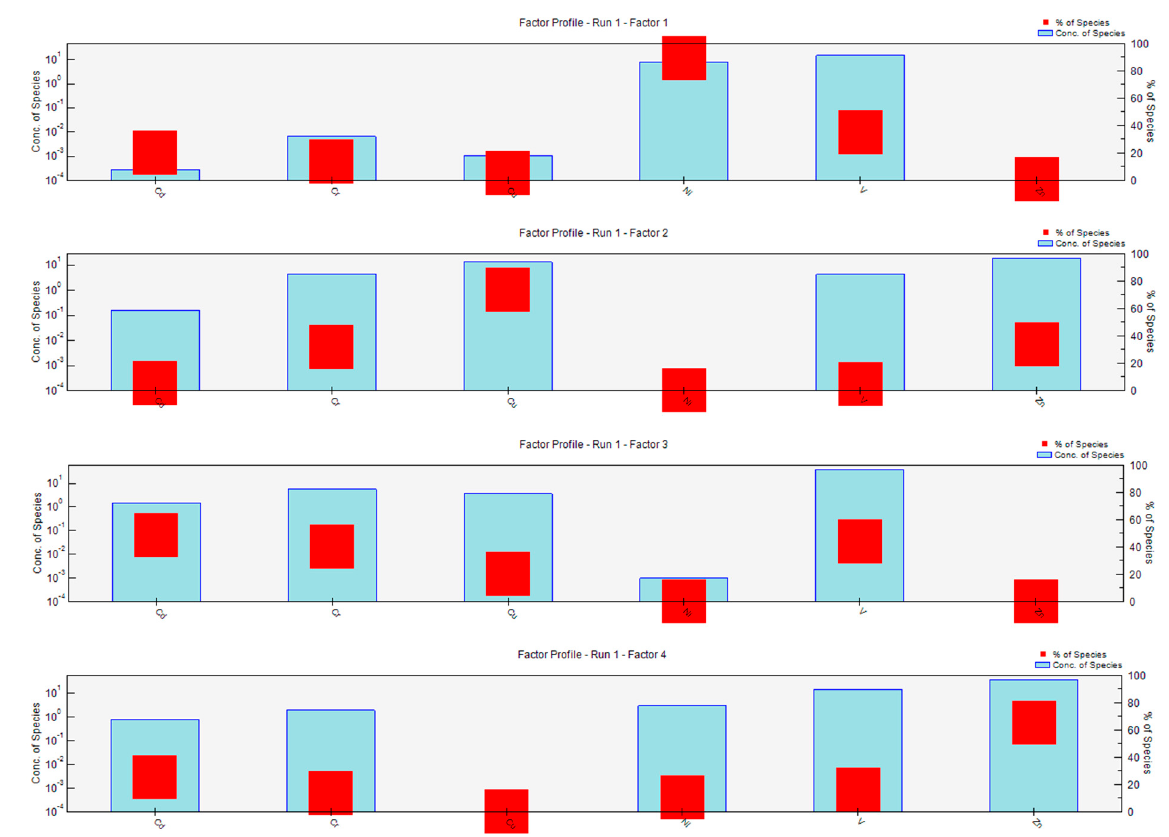
Figure 4. Summary of the PMF result, source profiles, and source contributions of heavy metals from soil.